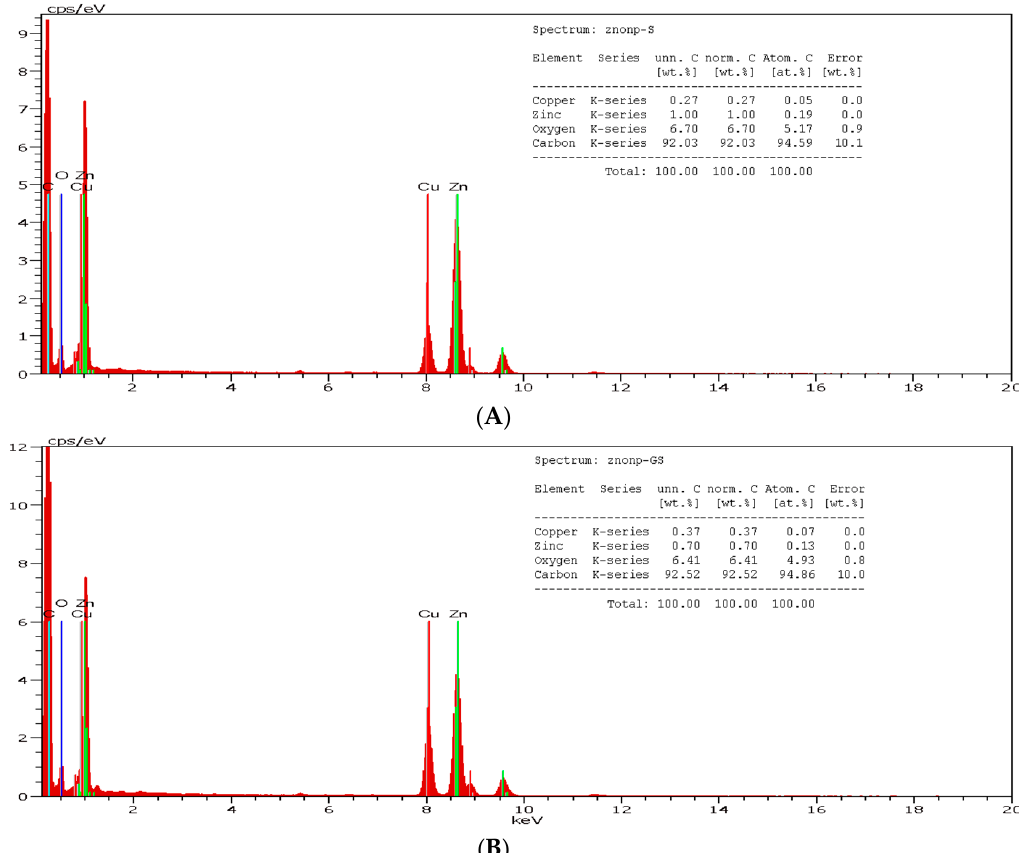
Figure 2. Energy-Dispersive X-ray Spectroscopy (EDX) spectrum of ( A ) ZnONP-S (procured from Sigma-Aldrich, USA) and ( B ) ZnONP-GS (green-synthesized in the current study) showing strong Zn-signals against background signals of C, O, and Cu.